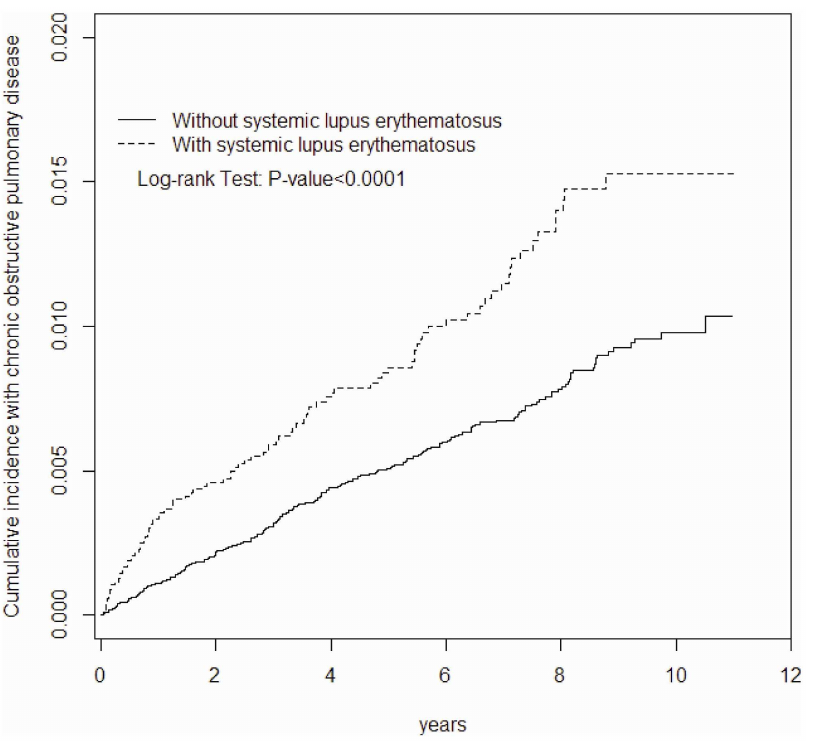
Figure 1. Cummulative incidence of COPD for subjects with and without systemic lupus erythematosus using the Kaplan–Meir method.